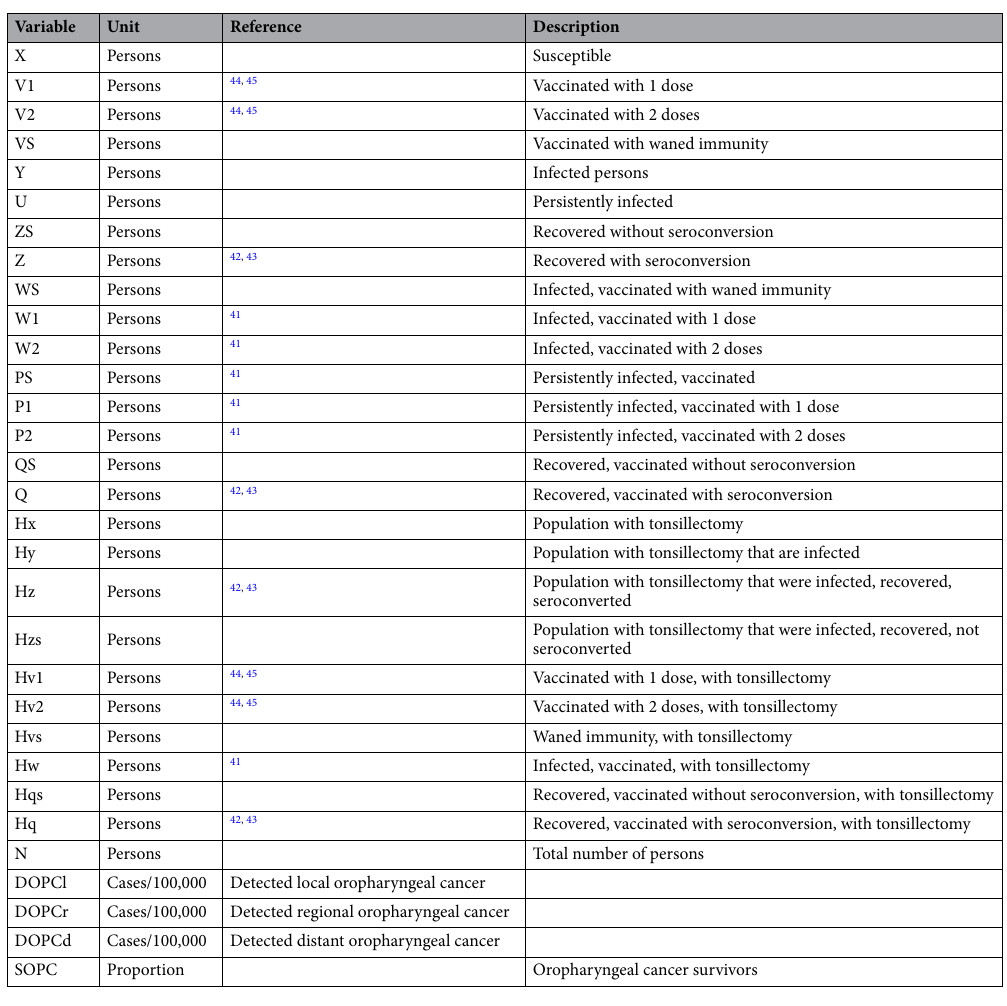
Table 5. Summary of